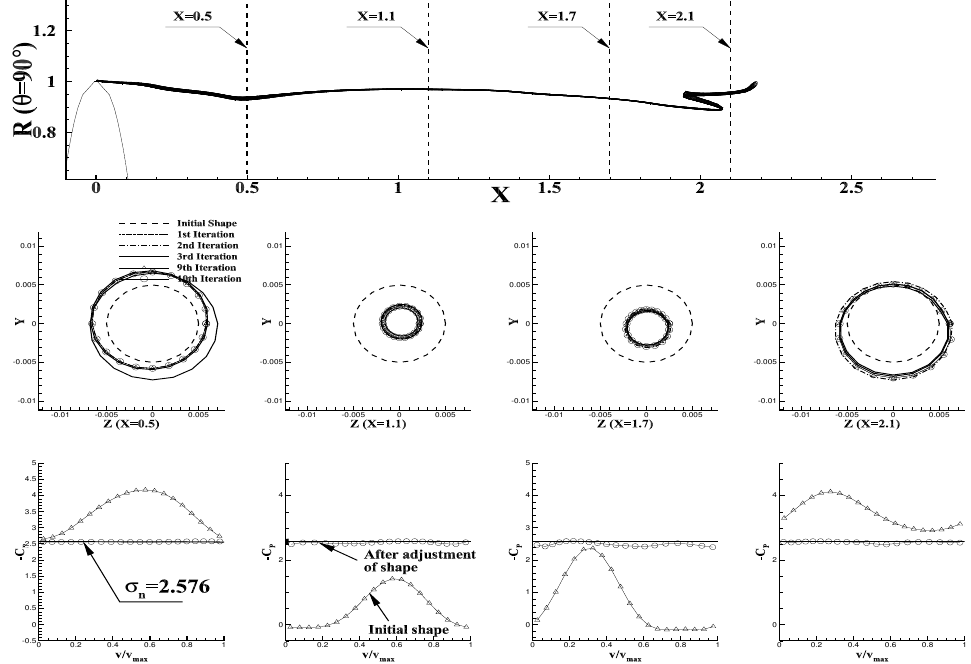
Figure 21. Projected view of the developed tip vortex cavitation from the BEM at blade angle θ = 90 ◦ on X − R plane ( up ). Convergence history of the cavitation sections at the denoted downstream locations ( middle ). Pressure distributions on the tip cavity surface at the same locations from the initial and the converged shape ( bottom